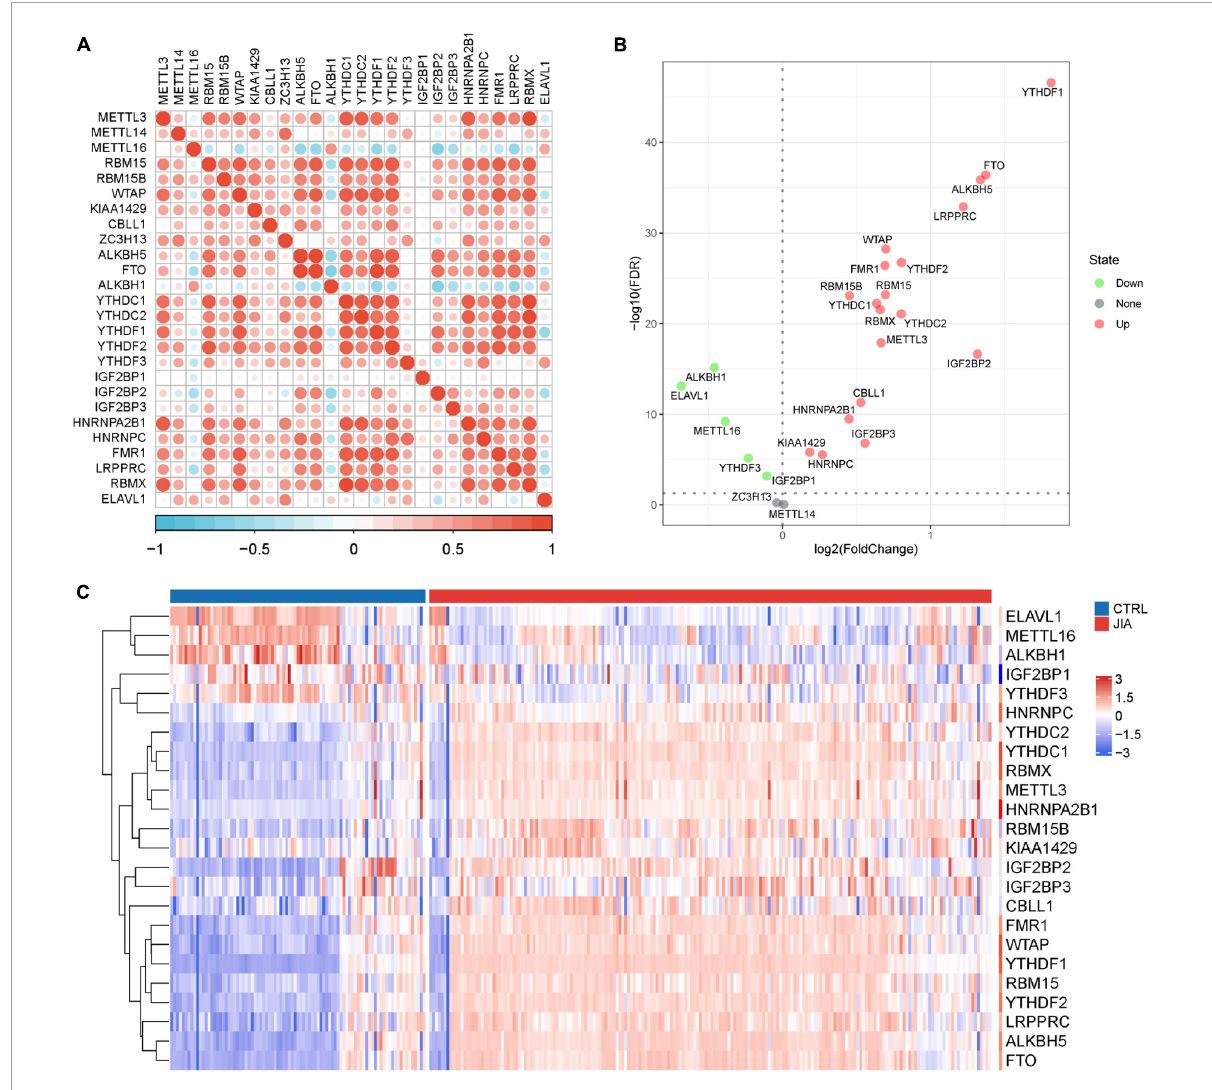
FIGURE1 The landscape of m 6 A regulators in juvenile idiopathic arthritis (JIA). (A) The co-expression network of 26 m 6 A regulators. The upper triangle is the network in all samples, and the lower triangle is the network in just JIA samples. (B) The volcano plot shows the differential expression of m 6 A regulators between JIA and healthy controls samples. (C) The heatmap plot of 24 significantly differentially expressed m 6 A